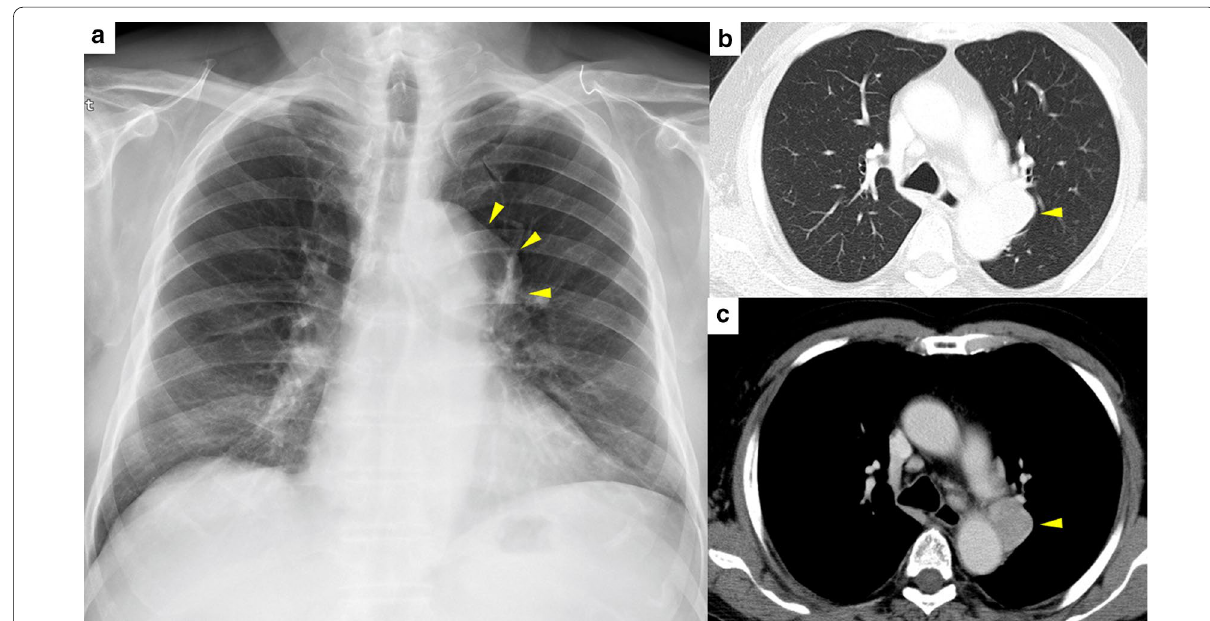
Fig. 1 Preoperative imaging. a Chest X-ray showed an abnormal mass in the left mediastinum (yellow arrowheads). b Enhanced computed tomography of lung field (yellow arrowheads). c Enhanced computed tomography of mediastinal field; the left mediastinal mass was a homogenous round-shaped 3.8 2.4 cm in diameter (yellow ×